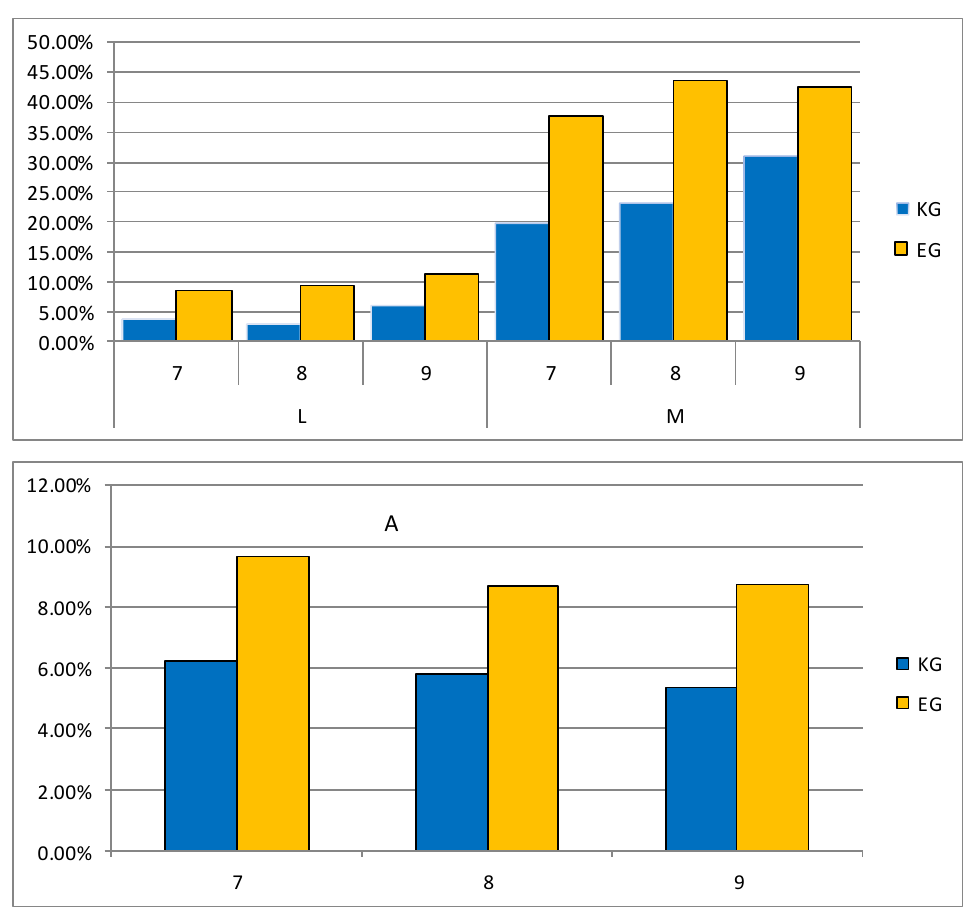
Fig.1. Percentage increment of physical qualities’ indicators in control (CG) and experimental (EG) groups. 7, 8, 9 – age in years, L – Long jump from the spot (cm); M – Forward torso bending from standing position (cm), CG – control group, EG – experimental group; t1 – 30 meters’ run (sec.); t2 – Shuttle run 4х9 m (sec.); A – Pressing ups in lying position (quantity of